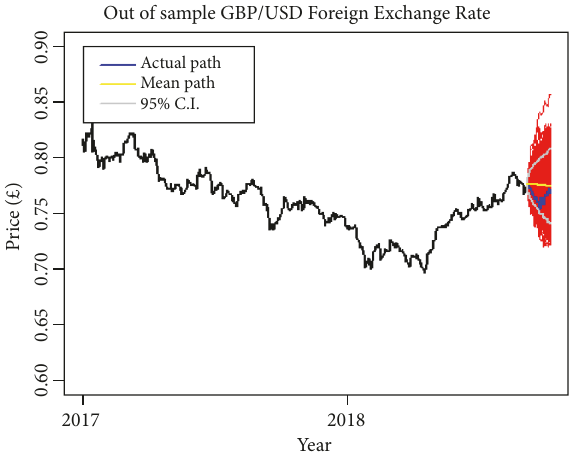
Figure 7: Visual Plot of the Simulated GBP/USD FX